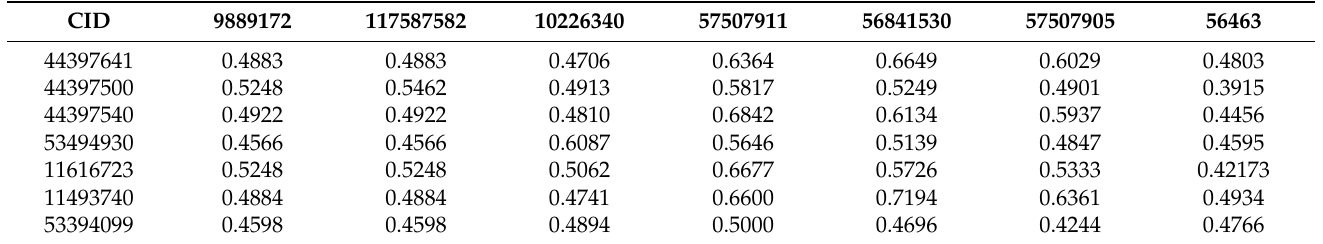
Table 5. Similarities of pairs of atoms belonging to pair of molecules from Benzoylindoles and Phenylacetylindoles.